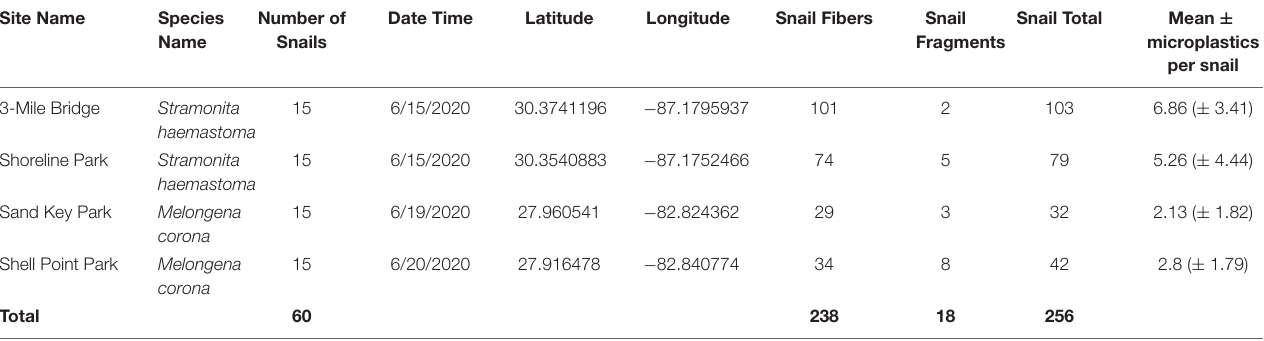
TABLE 2 | Microplastics identified for snail tissue